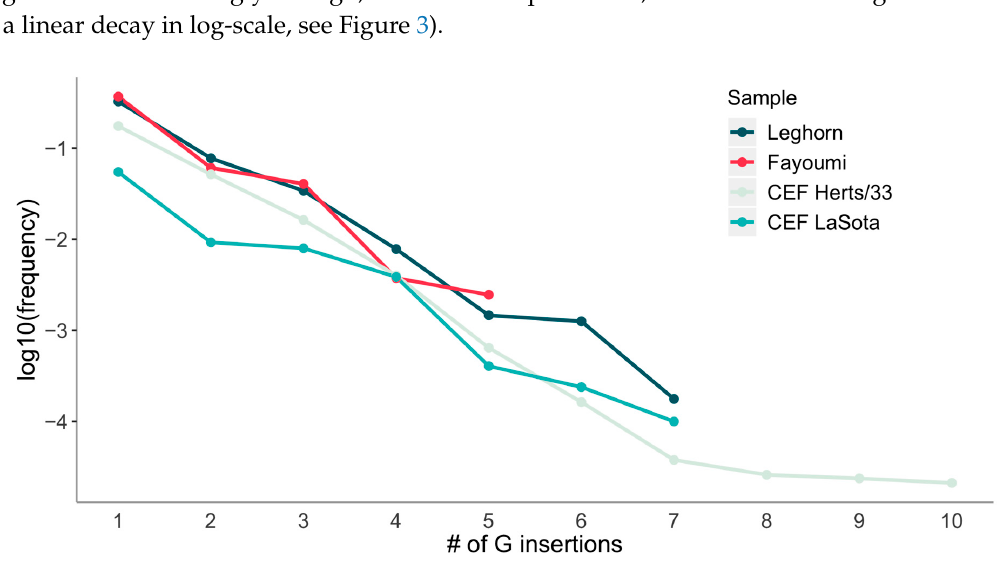
Figure 4. Log-plots of mRNA fraction as a function of insertion length, presented for each sample separately. Straight lines show the linear regressions for each experiment (the dotted line corresponds to the “Poisson-weighted” regression).